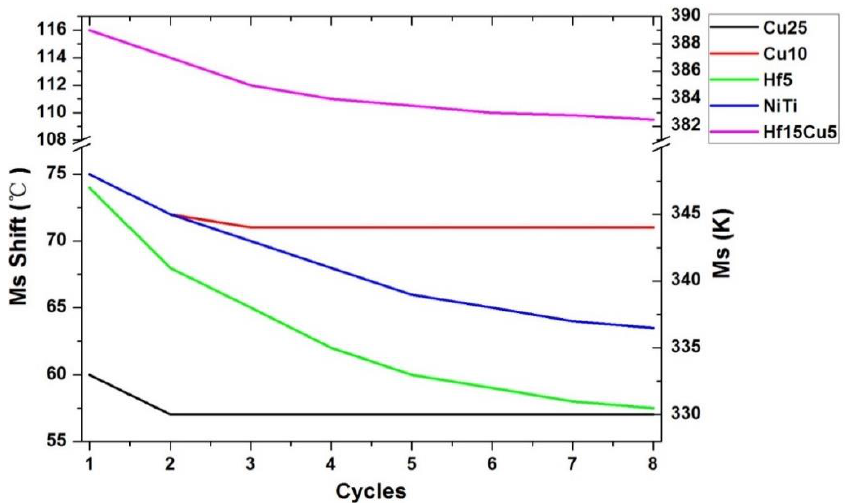
Figure 1. Reduction of M s of Ti-Ni-based SMAs with increasing thermal cycles. The labels Cu25, Cu10, Hf5, NiTi, Hf15Cu5 represent the thermal stability of Ti 51 Ni 24 Cu 25 , Ti 51 Ni 39 Cu 10 Ti 46 Ni 49 Hf 5 , Ti 51 Ni 49 and Ti 36 Ni 44 Hf 15 Cu 5 ,